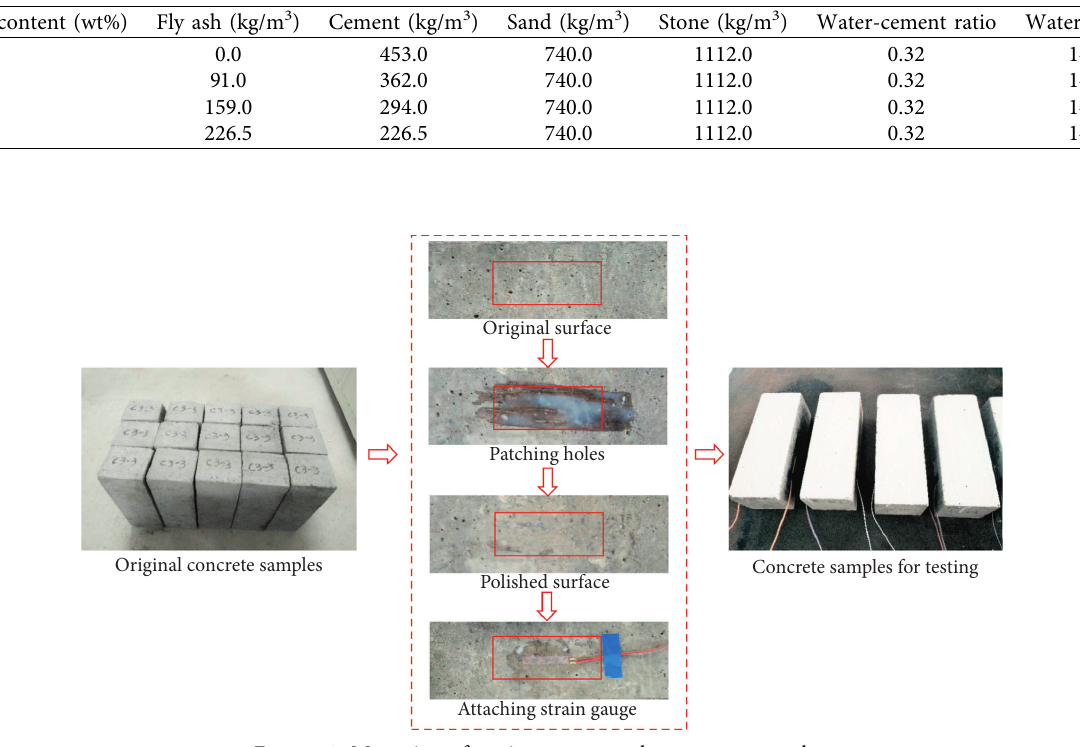
Table 2: Mixing ratios of the concrete.